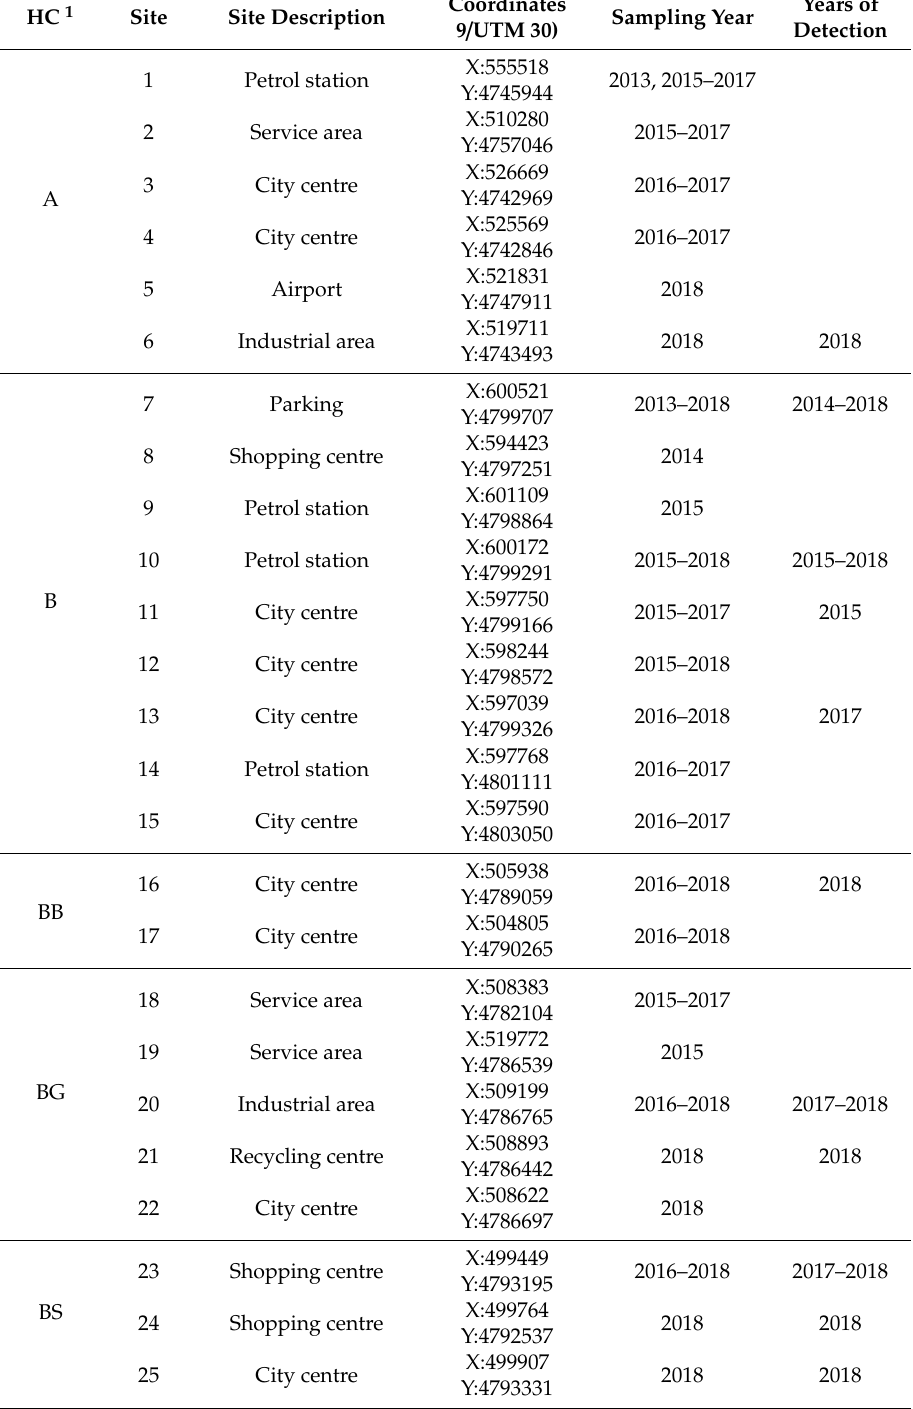
Table 1. Sampling sites description and year of detection of Ae. albopictus